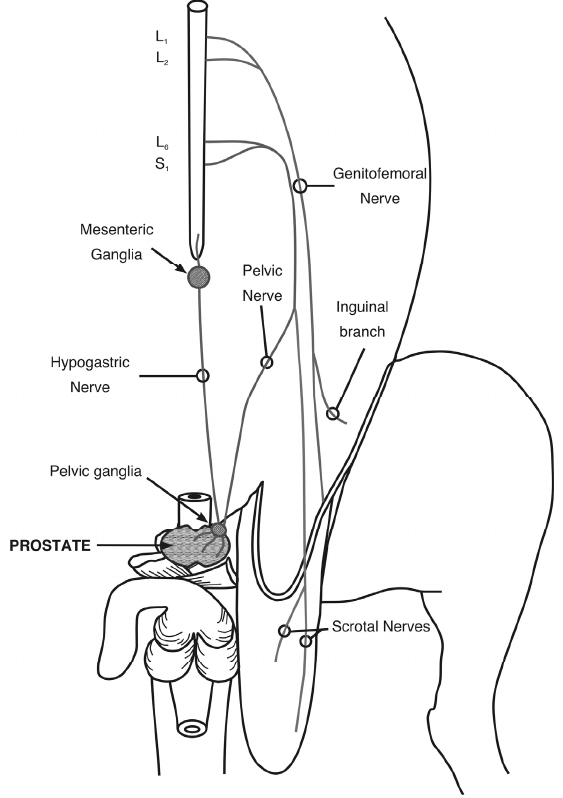
Fig. 1 – Somatic (afferent) and autonomic (efferent) nerves in the pelvic area. The integration of the nerves occurs in the lumbar and sacralsegmentsofthespinalcord. Thetransectedafferentnerves,scro- tal and genitofemoral nerves, supply the scrotal and groin epithelium, which are mechanically stimulated during copulation. The transected efferent nerves, pelvic and hypogastric nerves, innervate the prostate gland and other